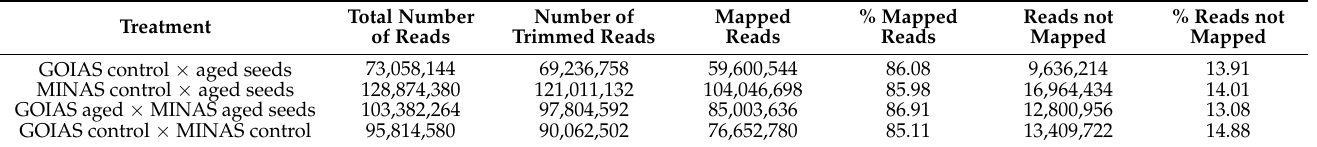
Table 2. Number of reads obtained from sequencing on the Illumina HiSeq2500 ® platform of embryonic axes of A. fraxinifolium seeds from treatments without and with an induced aging process. Number of Mapped % Mapped Treatment Total Number of Reads Trimmed Reads Reads